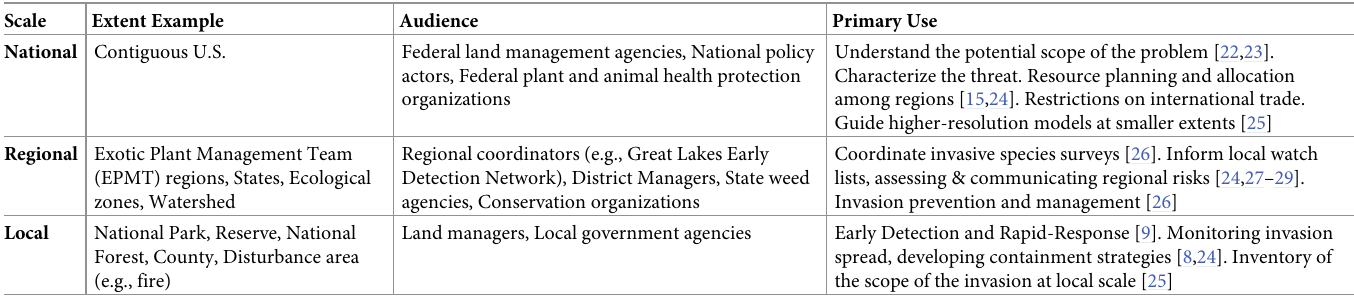
Table 1. Invasive species distribution model interpretation scales (national, regional, local) and their audience, use and select examples from the